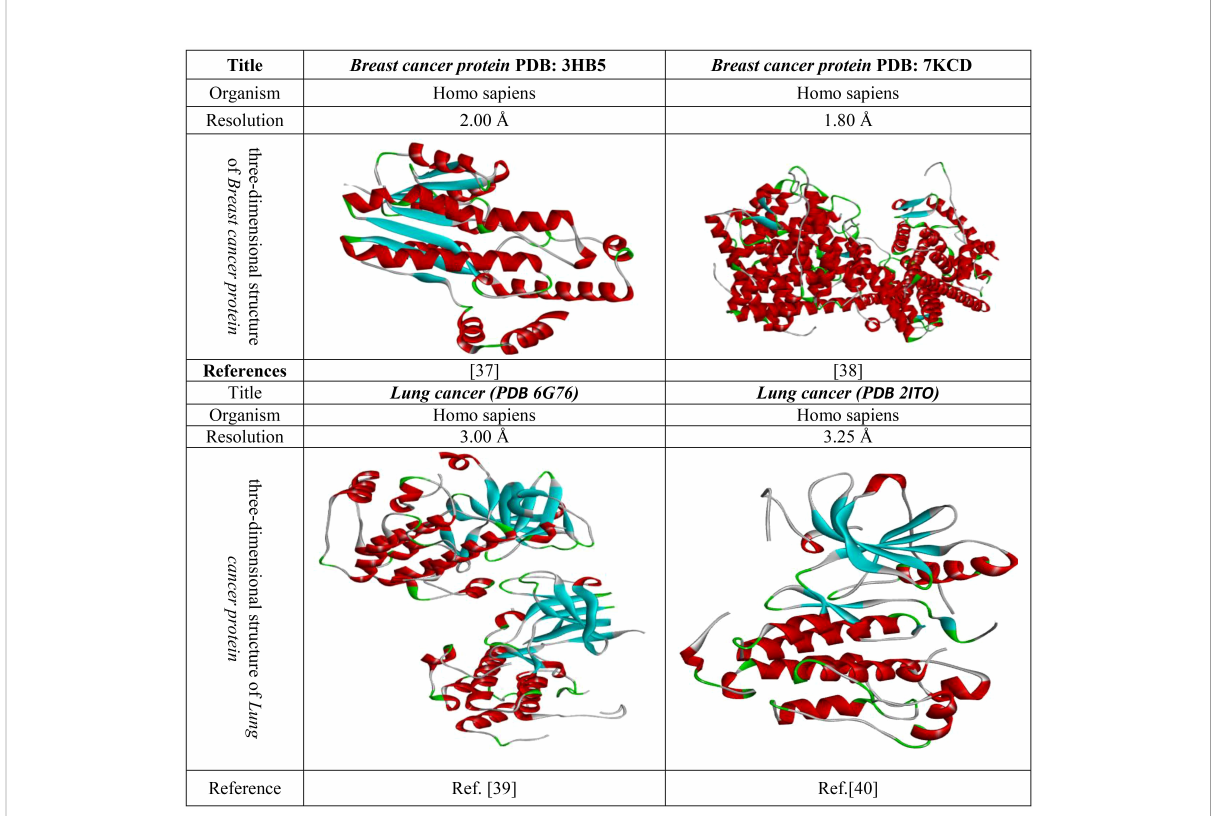
FIGURE 3 Three-dimensional protein structure of breast and lung